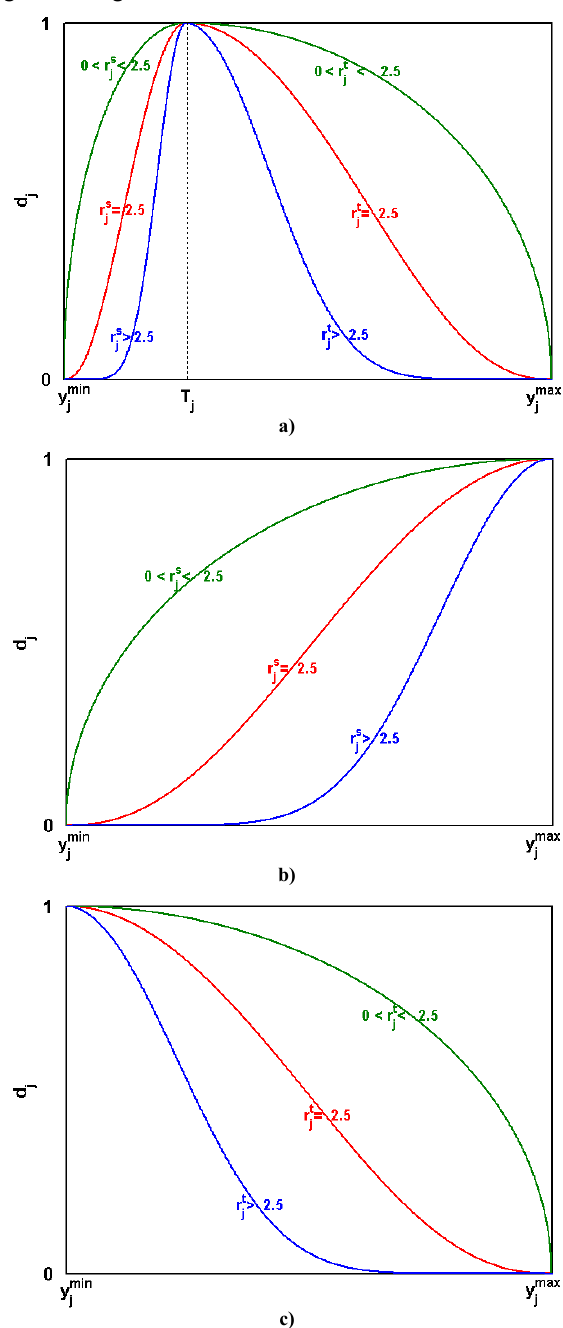
(ACO) algorithm, tabu search (TS) algorithm, artificial bee colony (ABC) algorithm, differential evolution algorithm, imperialist competitive algorithm (ICA)